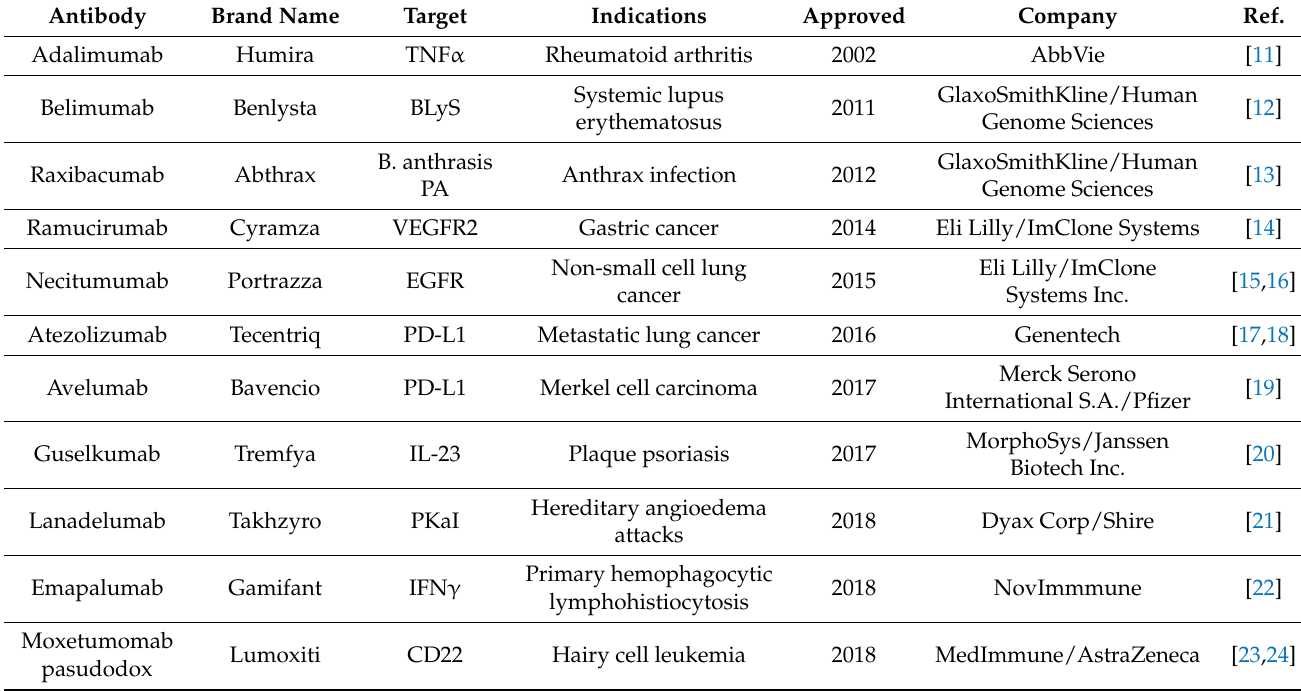
Table 1. FDA-approved antibody-based drugs from combinational antibody